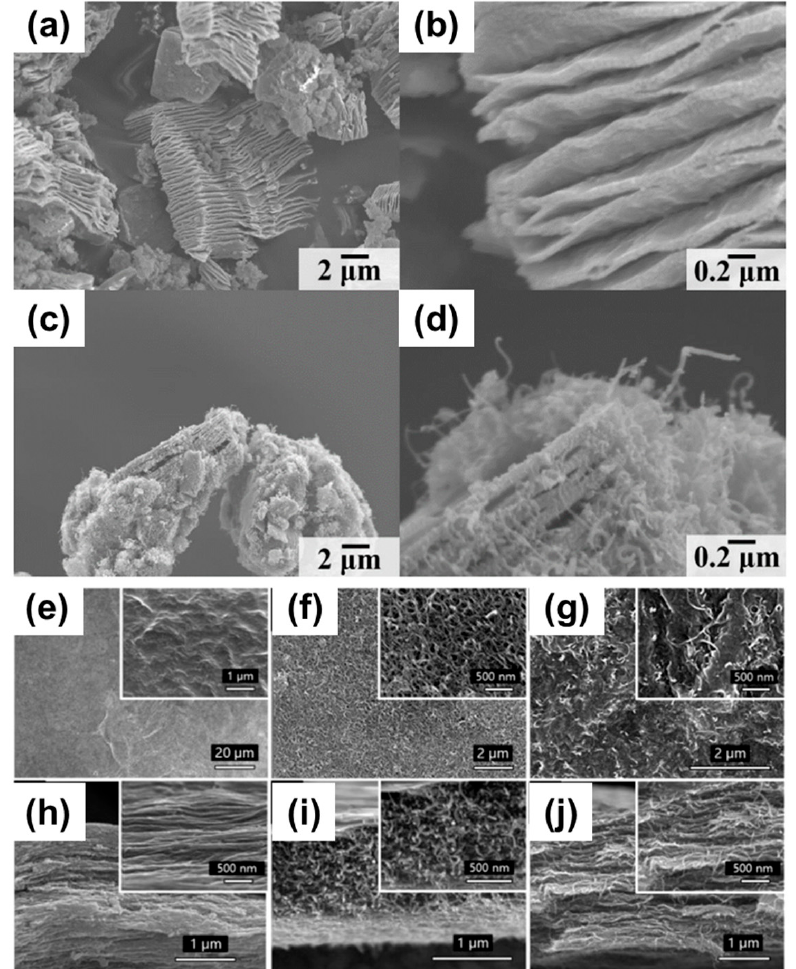
Figure 5. ( a – d ) SEM images at different magnifications of ( a , b ) as-received Ti 3 C 2 T x and ( c , d ) Ti 3 C 2 T X -Fe 3 O 4 -CNT. Reproduced from ref. [5] under the Creative Commons Attribution 4.0 International